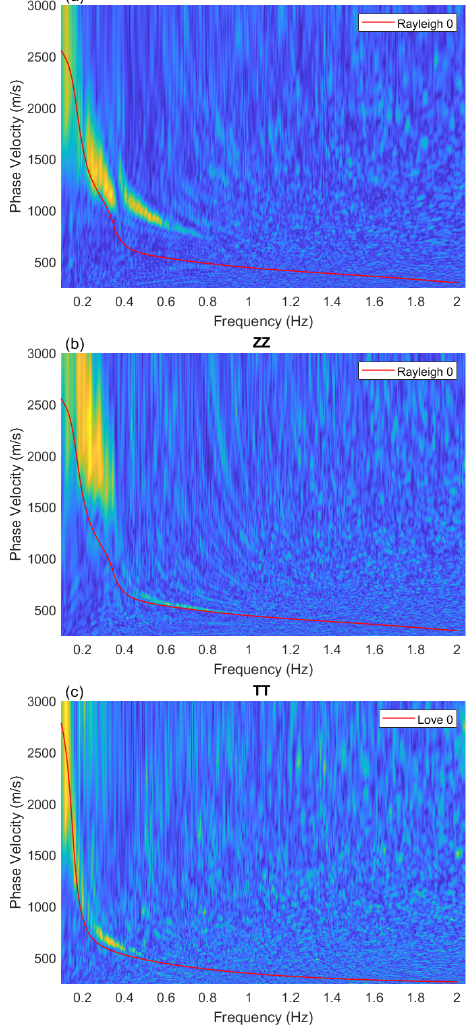
Figure 8. Multichannel analysis of surface waves [27] of the reference cross-coherences shown in Figure 7 for components ( a ) RR, ( b ) ZZ, and ( c ) TT, visualized in a power plot. The red lines indicate the fundamental dispersion curves of ( a , b ) Rayleigh and ( c ) Love waves, obtained with the adjoint method [26].